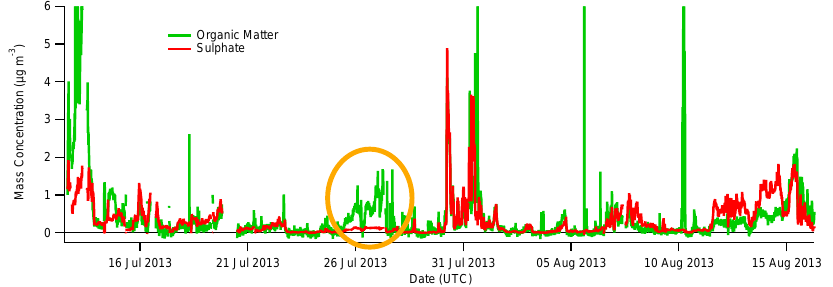
Figure 3. AMS-derived organic and sulfate mass concentrations, as calculated using the standard fragmentation tables (see Sect. S2 in the Supplement). Other commonly reported species (nitrate and ammonium) were below detection limit outside of areas in close proximity to ports in the UK or Svalbard and thus considered irrelevant. The period of the main case study is highlighted in orange.